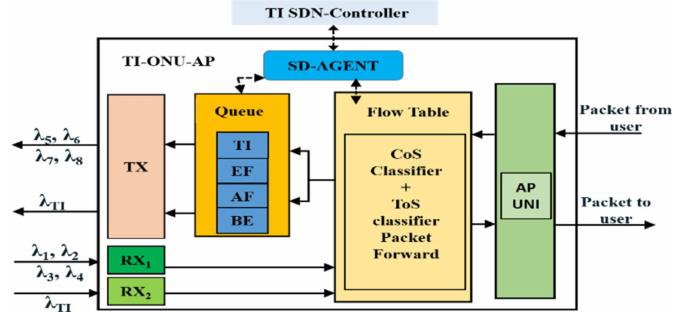
Figure 3. TI-SD-ONU-AP Architecture.